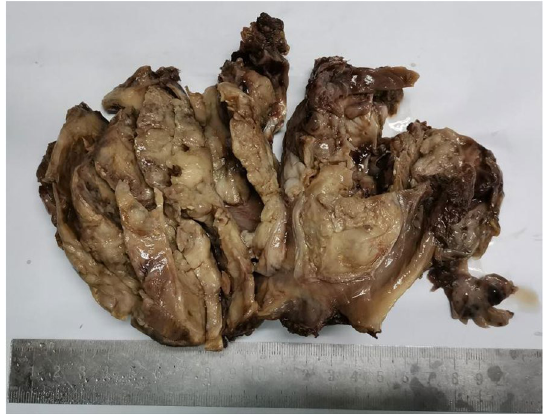
Fig. 2 Macroscopic aspect the color of the solid area of the mass was gray white and gray yellow